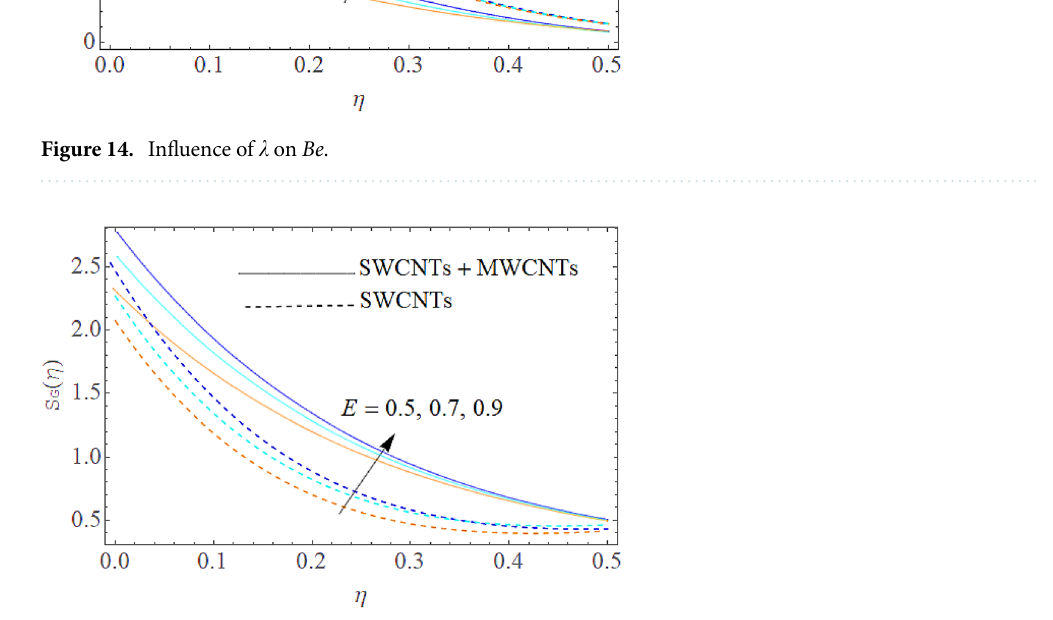
Figure 15. Outcome of E on S G